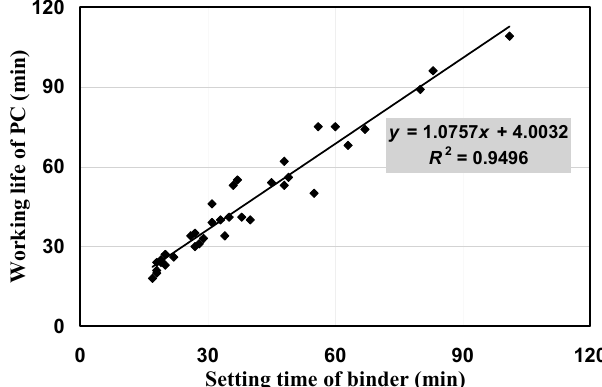
Figure 6. Relation between binder’s setting time and acrylic polymer concrete’s working life at sub-zero temperatures.